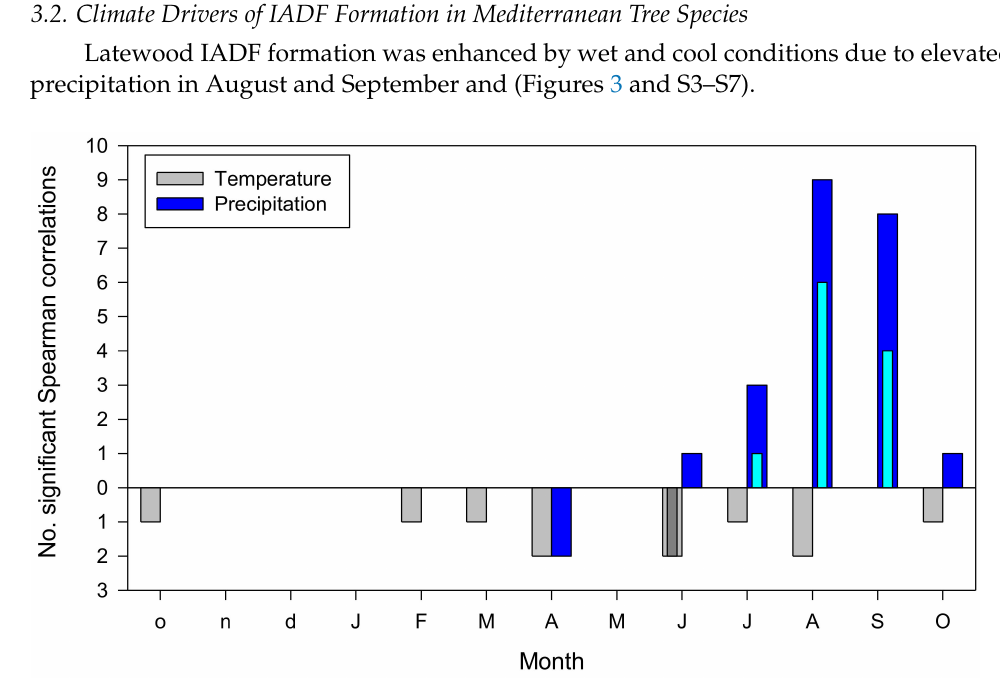
Figure 3. Summary of climate–IADF relationships calculated at monthly scale in the six study tree species. Monthly climate variables are mean temperature (grey bars) and precipitation (blue bars). Months abbreviated by lowercase and uppercase letters correspond to the previous and current years, respectively. Wide and narrow bars correspond to Spearman correlations coefficients ( r s ) with significance levels lower or equal to 0.05 and 0.01,